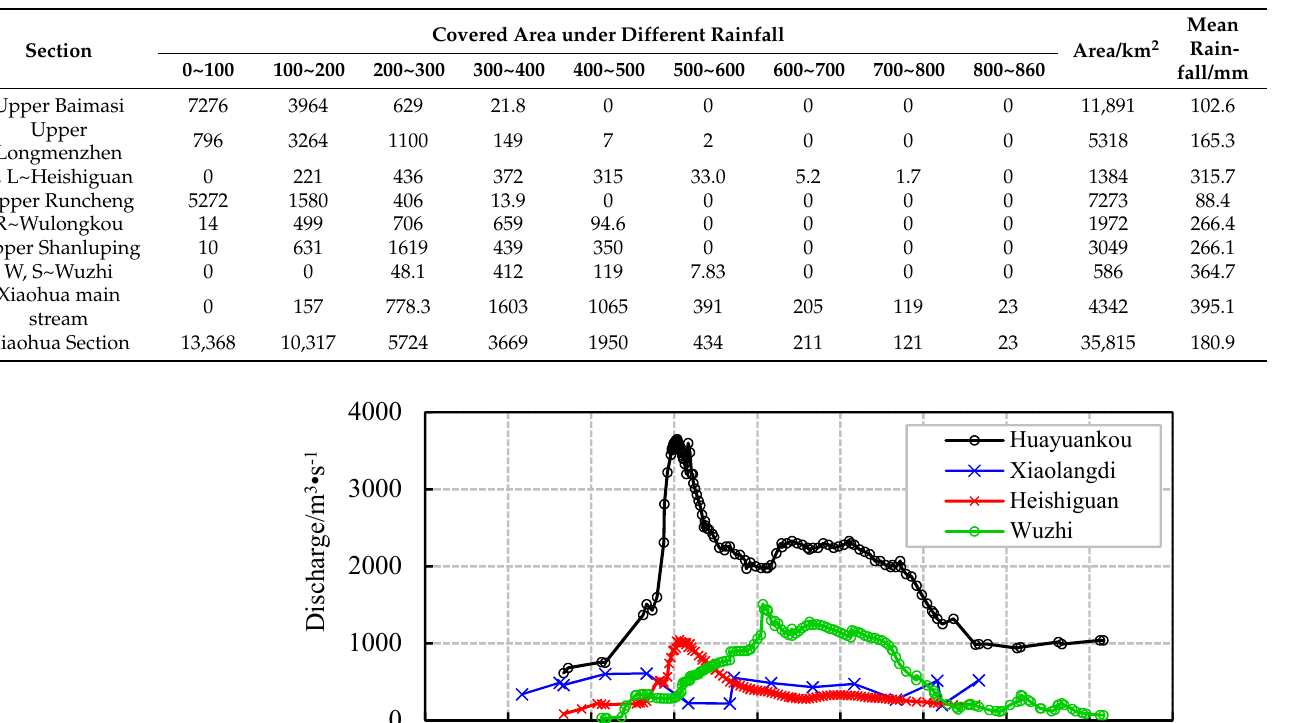
Table 2. The average rainfall in each region on July 18 to 22 in the Xiaohua section.